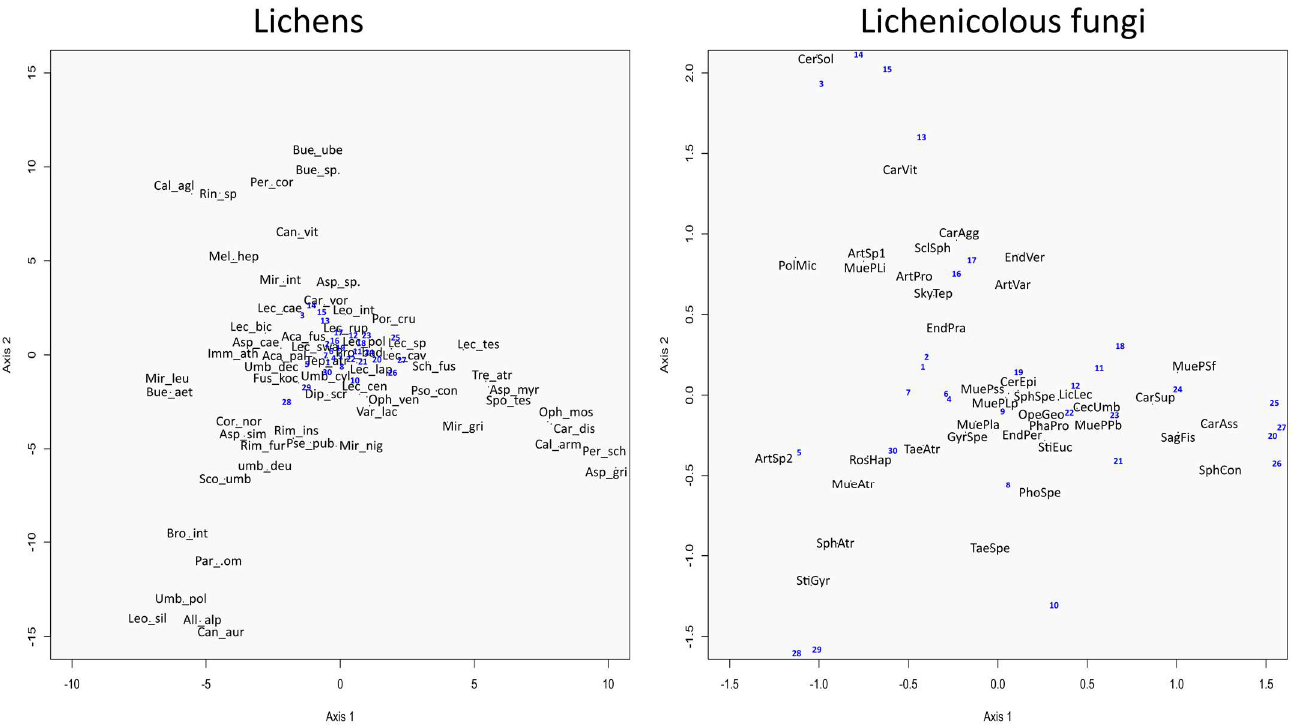
Figure 4. Predictive Co-CA plots of lichen (left) and lichenicolous fungi (right) species composition performed using abundance data. In the plots, species names (in black) are abbreviated up to six letters; numbers (in blue) refer to the sampling subplots.